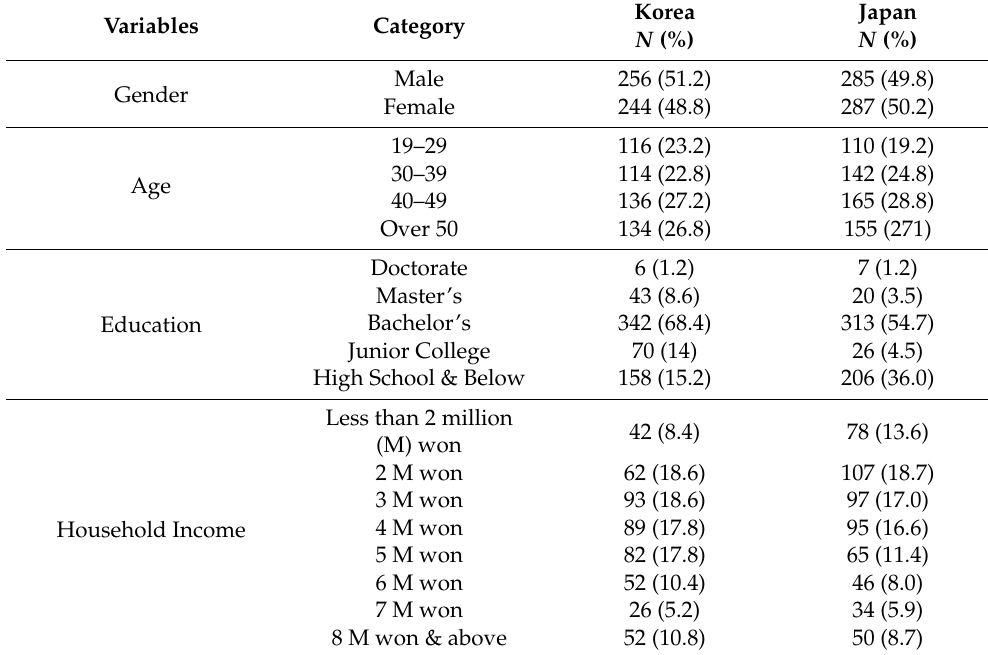
Table 1. Frequency of